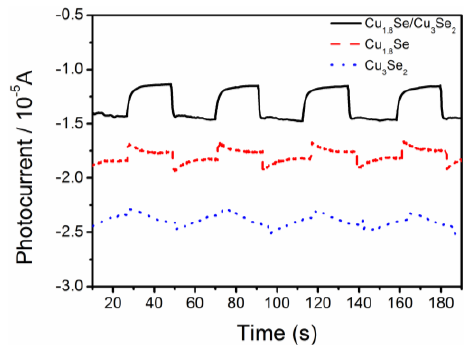
Figure 8. The photocurrent responses of copper selenides in 0.5 M Na 2 SO 4 electrolyte under visible light. visible